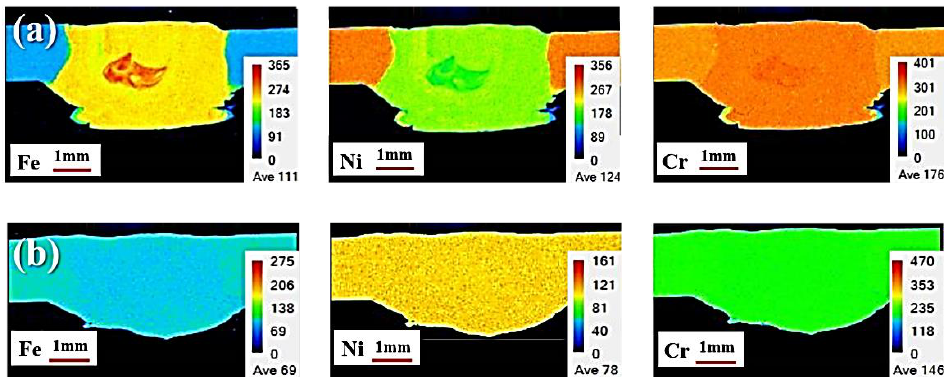
Figure 2. Component segregation of GTA welds produced using various fillers: ( a ) STS 308L and ( b ) HEA.